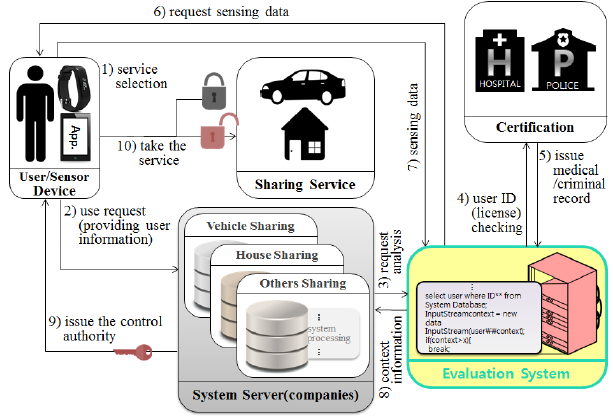
Figure 7. CPS structure for measuring a user’s reliability.